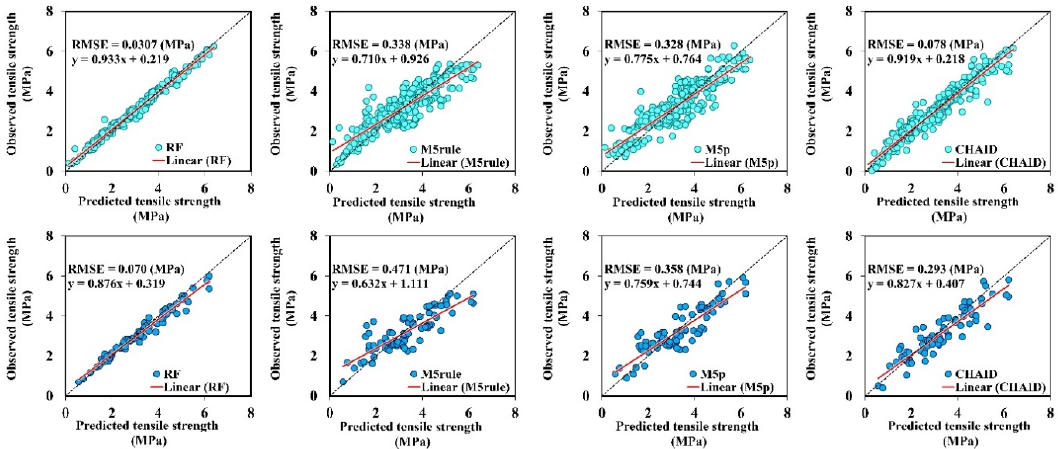
Figure 6. Scatter plots of the observed and simulated TS for training (light color) and testing (dark color) of the proposed models.